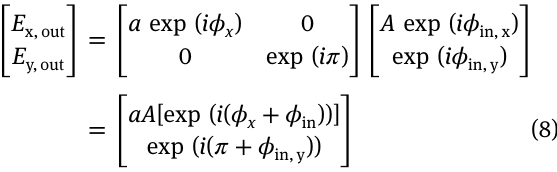
two orthogonally polarized components of the reflected light in Figure 1 as a function of the GST crystallization level over a wide spectral range. It is clear that the proposed metasurface generally behaves as a reflective elliptical polarizer just by adjusting the GST crystallization level in the meta-atoms. However, by satisfying particular